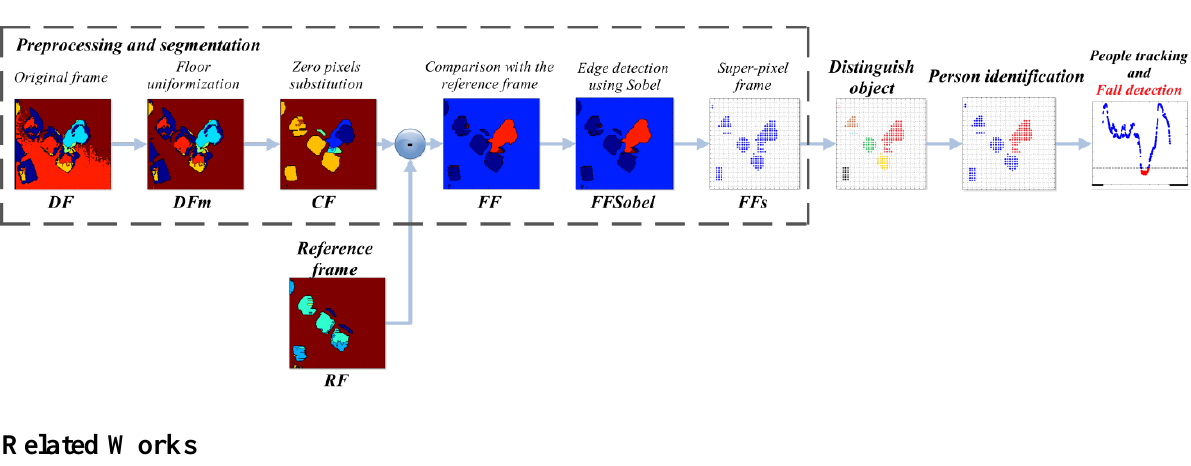
Figure 1. Overview of the fall detection